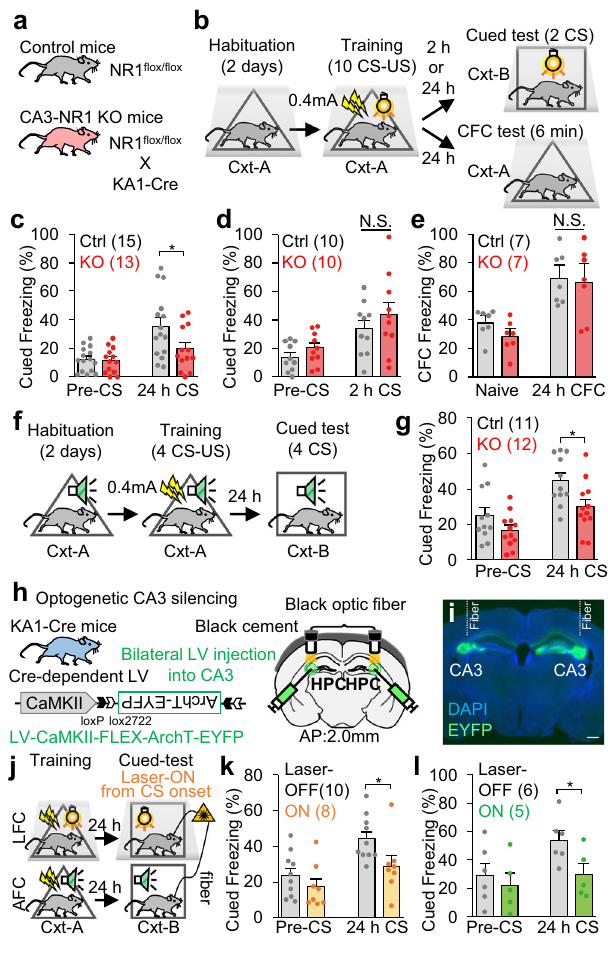
Fig.1|CA3NRsandCA3activityareimportantforcued-fearmemory.a Animals used in this study. b Light-cued-fear conditioning (LFC) task. c , d Cued freezing levels during ( c ) 24h long-term (two-tailed unpaired Student ’ s t test, P =0.046), and ( d ) 2h short-term, memory tests. e Contextual freezing levels during a 24h long-term memory test in the LFC task. f Auditory-cued-fear conditioning (AFC) task. g Cued freezing levels during the 24h long-term test in AFC task (two-tailed unpairedStudent ’ sttest, P =0.02). h Animalandvirusvectorusedforoptogenetic CA3silencing. i CoronalsectionofthehippocampuswithEYFP-expressingcells.All of the animals incorporated as data showed similar expression pattern. Scale bar, 500 μ m. j Scheduleforoptogeneticexperiment. k , l Cuedfreezinglevelsduringthe 24h long-term memory test in the ( k ) LFC (two-tailed unpaired Student ’ s t test, P =0.039),and( l )AFCtasks(two-tailedunpairedStudent ’ sttest, P =0.04). P values determined using an unpaired two-tailed t test (* P <0.05) ( c-e , g , k , l ). Graphs represent the mean±SEM, and circles within the graphs represent individual ani- mals. Numbers in parentheses denote the number of mice in each group used for the study. Lightning bolt, footshock; Light bulb, light CS; Cxt, context; Speaker, tone CS; HPC, hippocampus; AP, anterior-posterior; N.S., not signi fi cant. Detailed statistics are shown in Supplementary Data